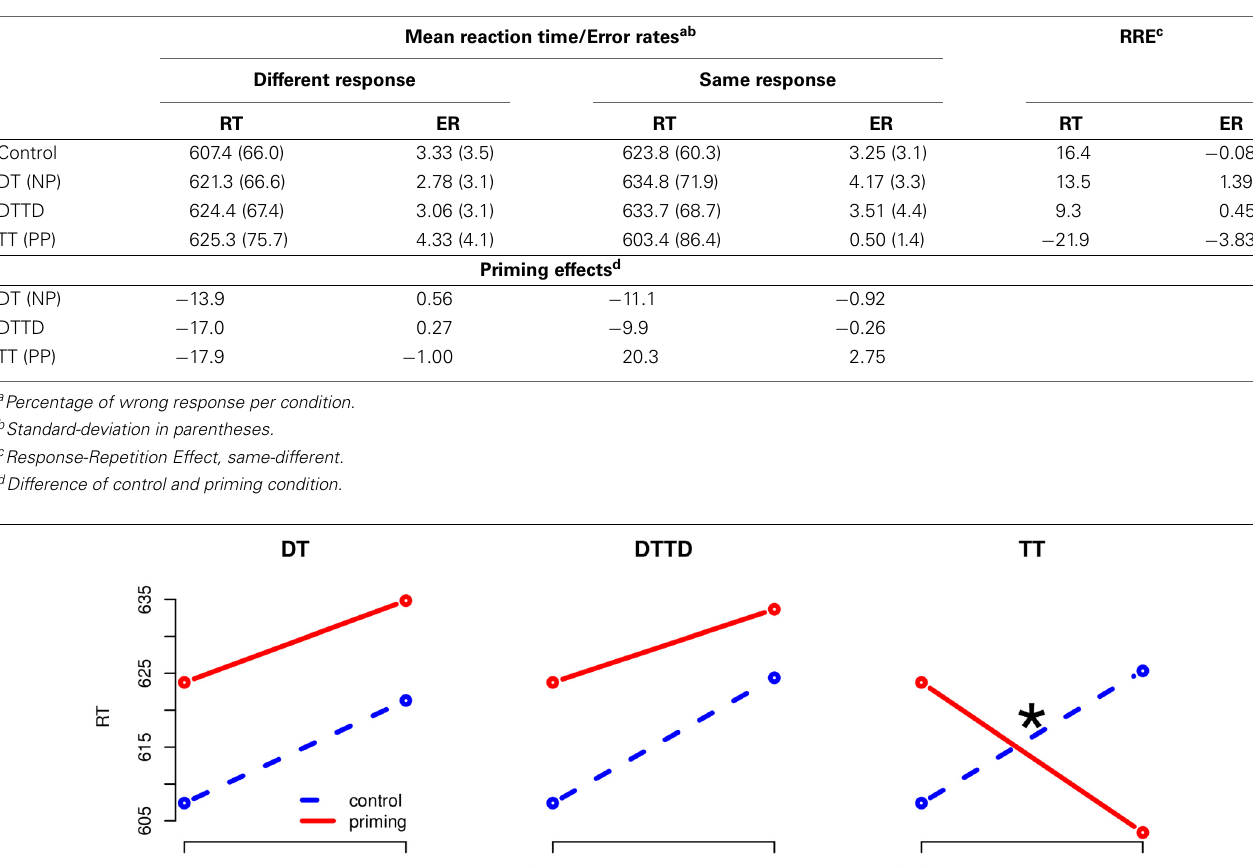
Table 1 | Summary of reaction times (RT) and error rates (ER) for Experiment 1.